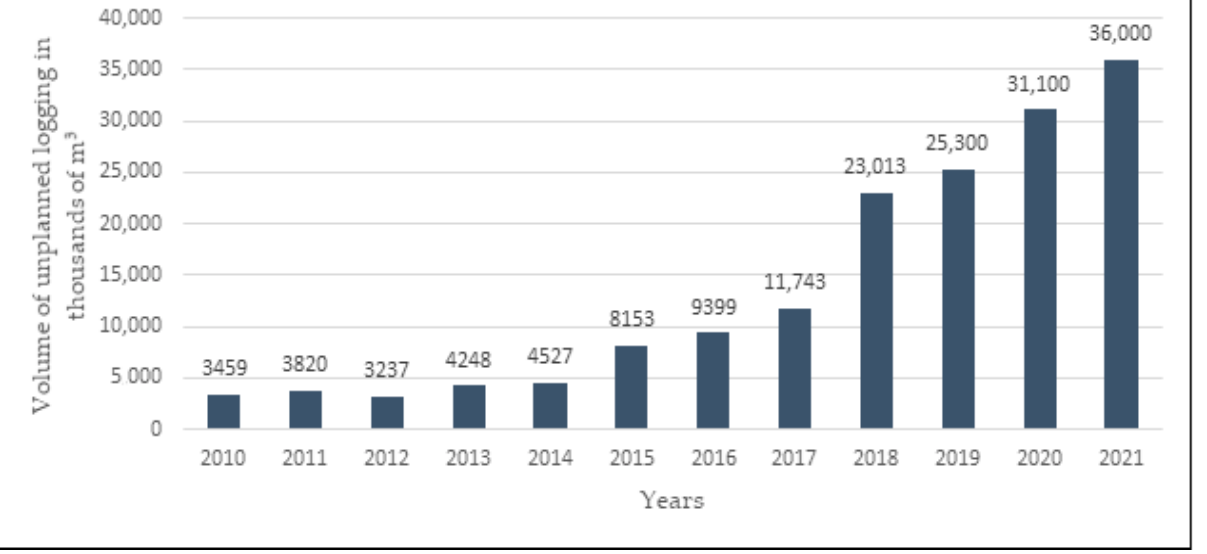
Figure 1. Volume of unplanned logging in the Czech Republic (from 2010 to 2020 and forecast for 2021); Source: Č SU (Czech Statistical Agency) 2020, Forestry.